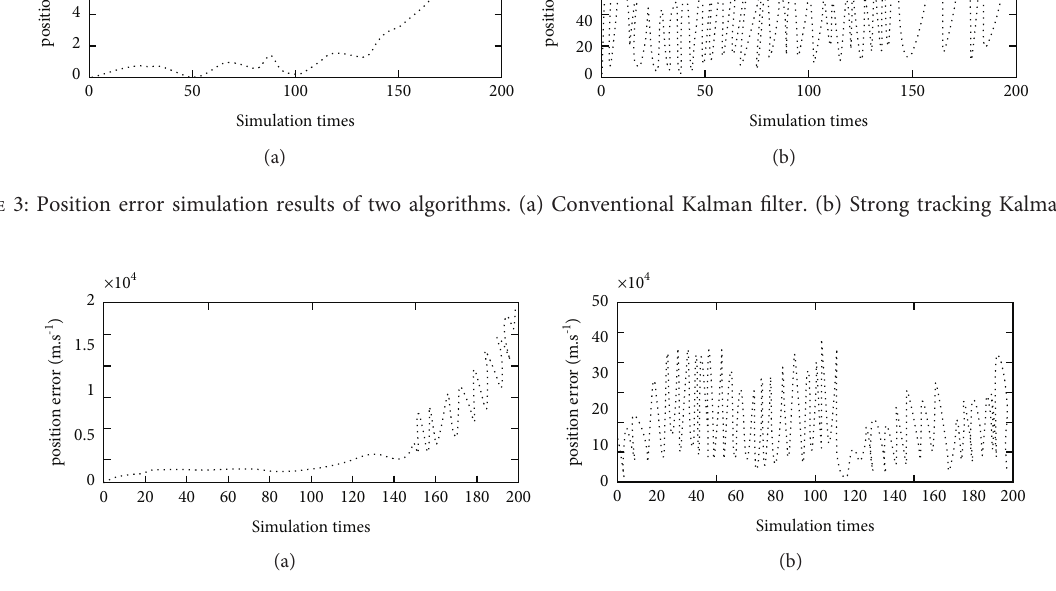
Figure 4: Speed error simulation results of two algorithms. (a) Conventional Kalman filter. (b) Strong tracking Kalman